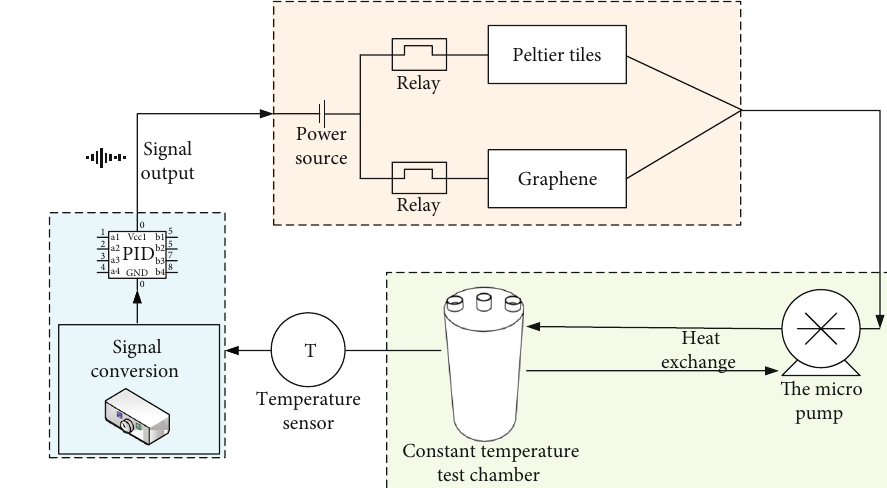
Figure 7: Schematic diagram of the insulation experiment system design.